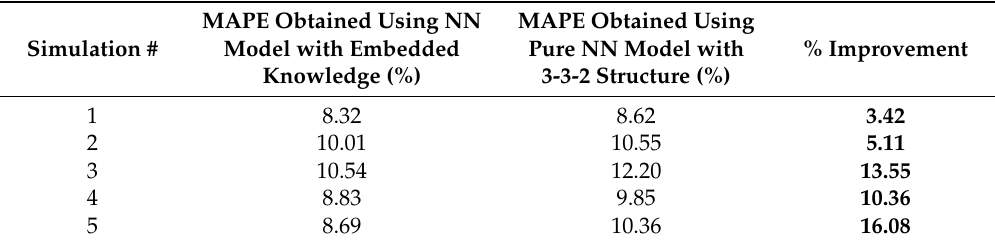
Table 3. Comparison of the MAPE obtained for the test set using the pure NN model with a 3-3-2 structure and the NN model with embedded knowledge.